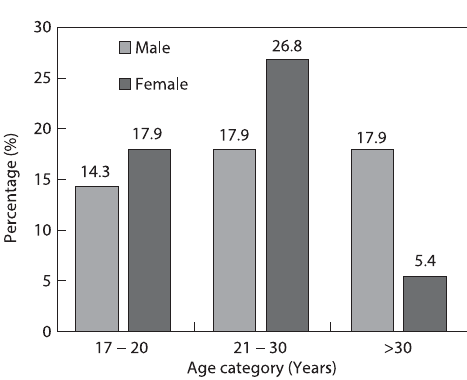
Figure 3: Distribution of children diagnosed with acute hepatitis A by age group and grade of hepatitis.